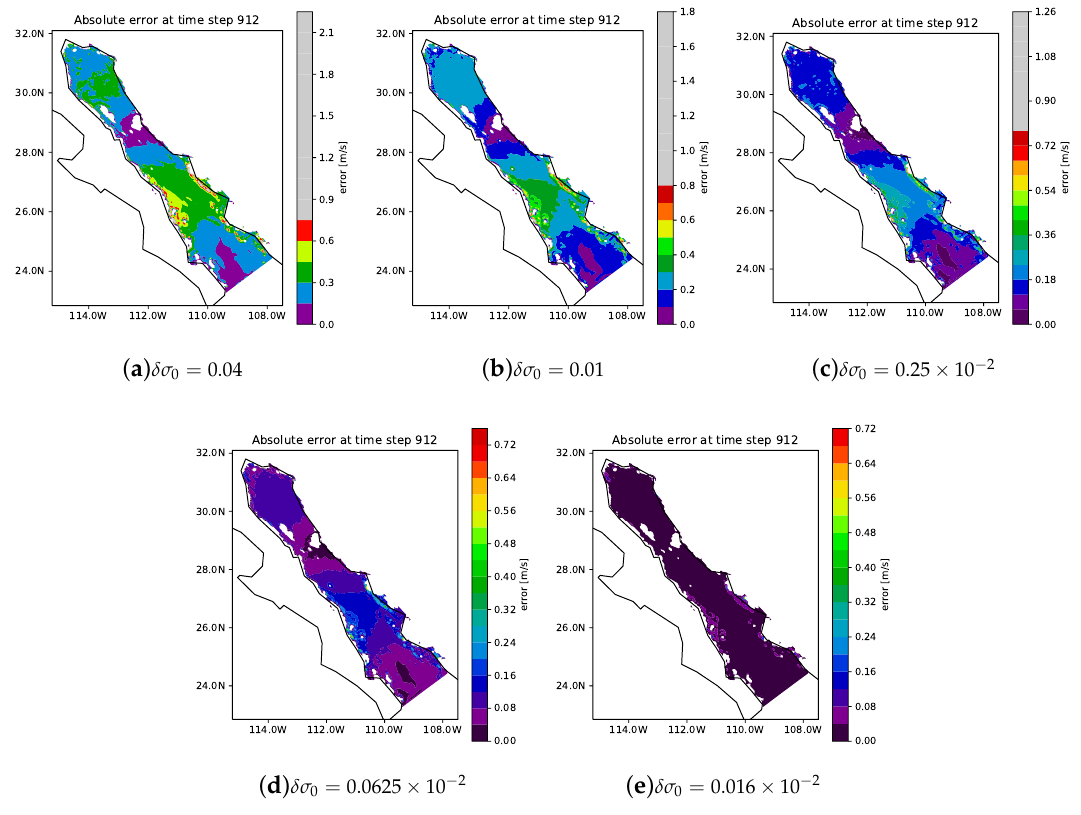
− v | , with n denoting the vertical layer δσ 0 = 0.0001 0 = n